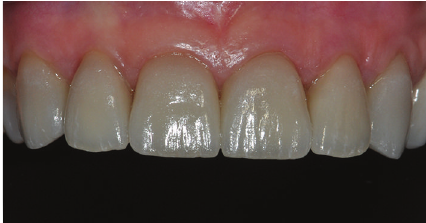
Figure 17: Follow-up 9 months after veneer